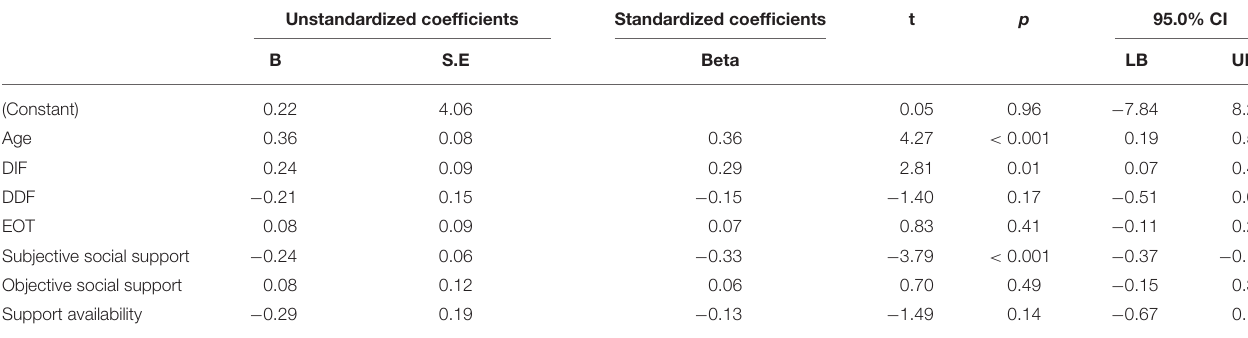
TABLE 4 | Predictors generated by Multivariate Logistic Regression with duration of methamphetamine use as dependent